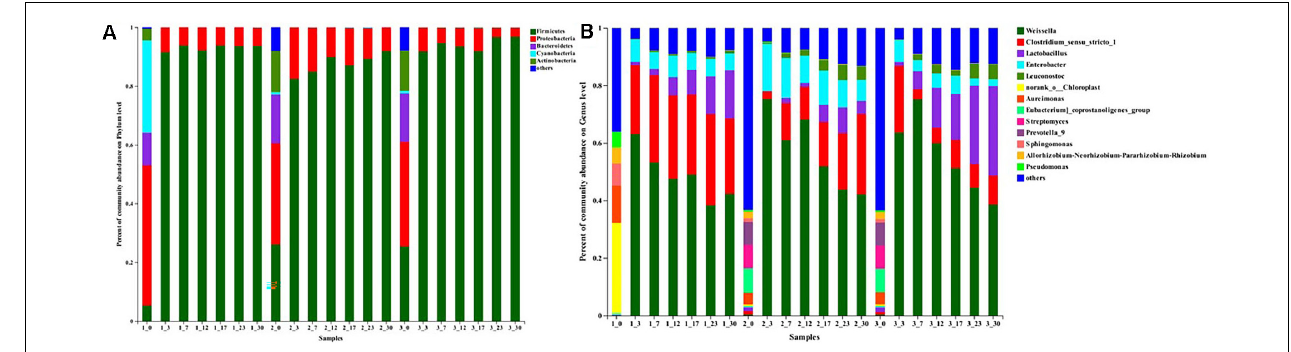
FIGURE 2 | Relative abundance (%) of microbial at the phylum (A) and genus (B) level during traditional northeast sauerkraut fermentation from different households. #1, #2, and #3 represented three different households. The number behind “ − ” (0, 3, 7, 12, 17, 23, 30) represented fermentation time (day).